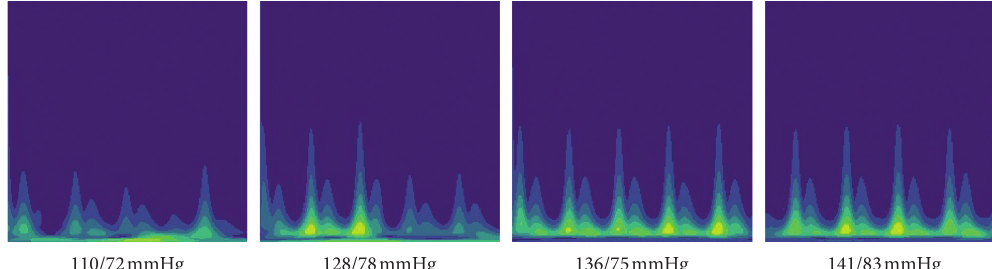
Figure 5: The image examples transformed from cgau1 for different blood pressure